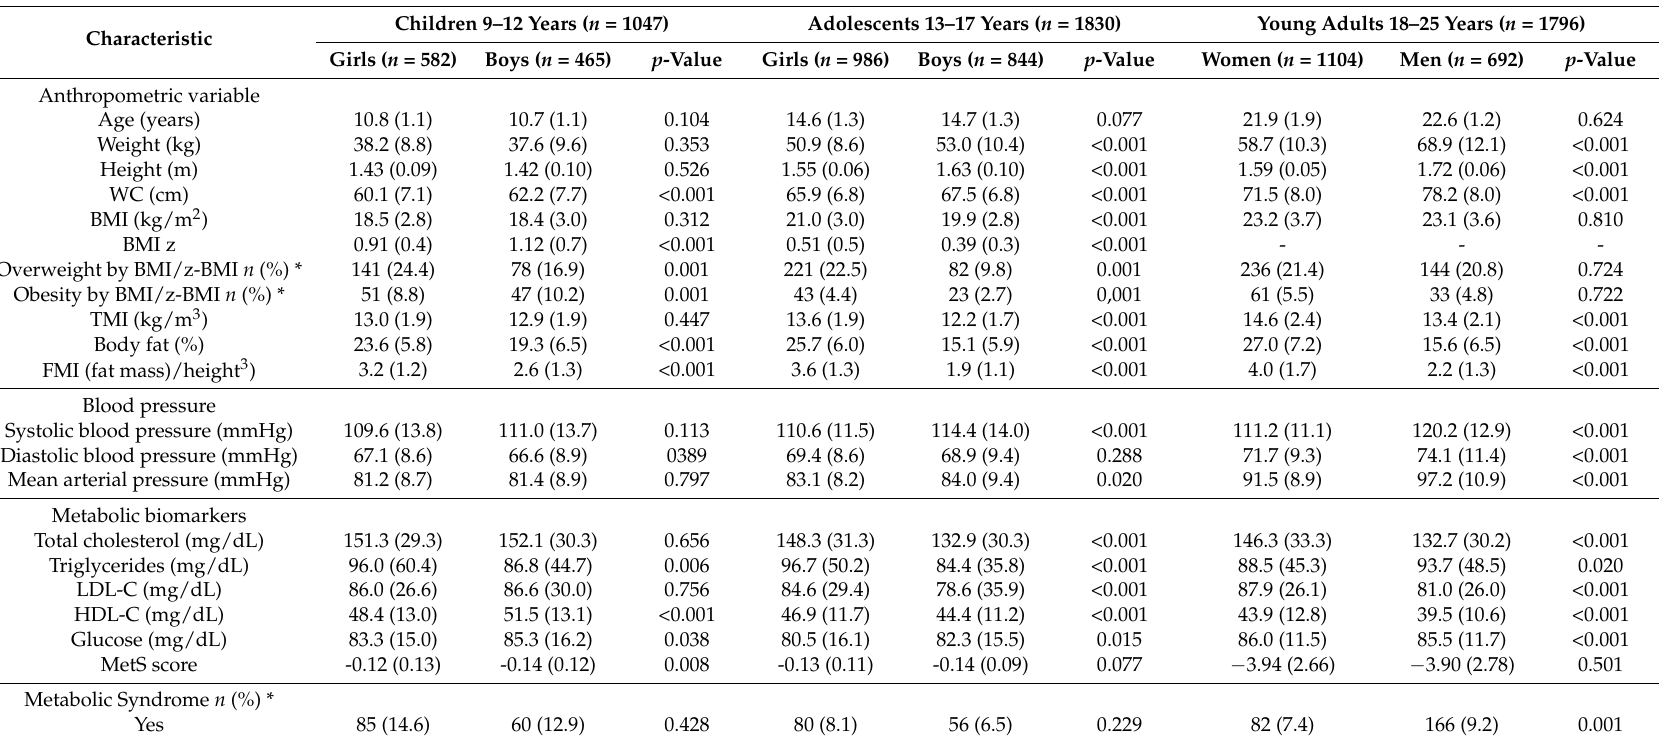
Table 1. Characteristics among a sample from Colombia (mean (standard deviation (SD)) or frequency